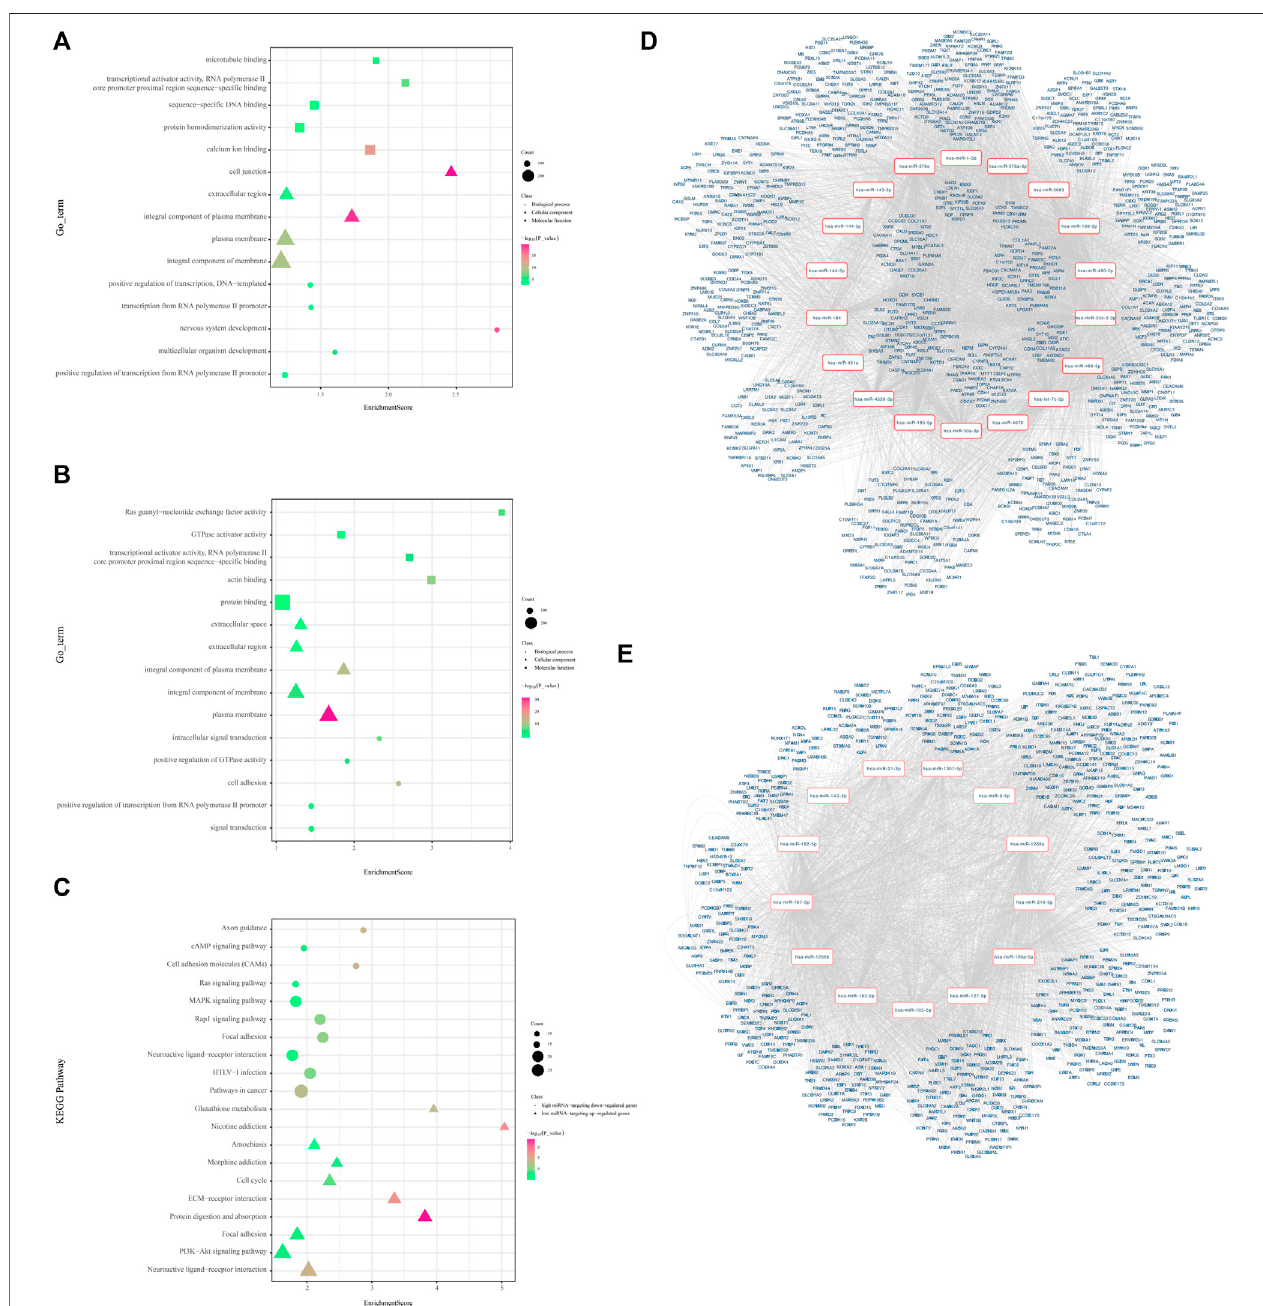
FIGURE 3 | Visualized regulatory network and enrichment bubble graph for miRNA-targeting DEGs. (A) Enrichment bubble graph for upregulated genes. (B) Enrichment bubble graph for downregulated genes. (C) KEGG enrichment bubble chart of low-expression miRNAs and upregulated genes and high- expression miRNAs and downregulated genes. (D) Regulatory network graph of 18 low-expression miRNAs. (E) Regulatory network graph of 13 high- expression miRNAs.